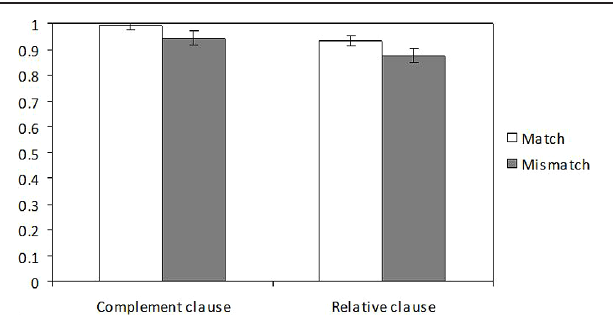
FIGURE 4 | Accuracy proportions in the speeded grammaticality judgment task of Experiment